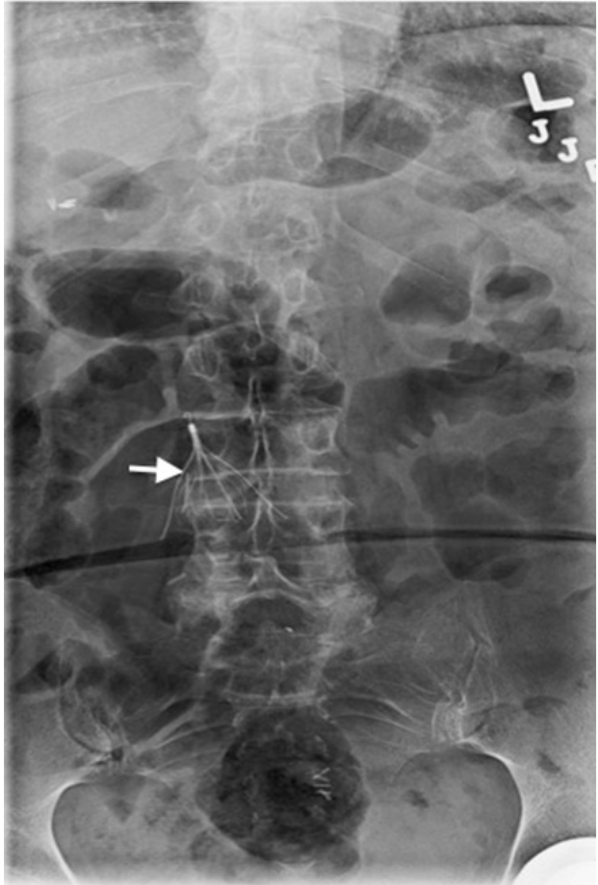
Figure 1. Posterior to anterior view of lumbosacral spine. Arrowhead demonstrates fracture and displacement of the posterolateral inferior vena cava filter